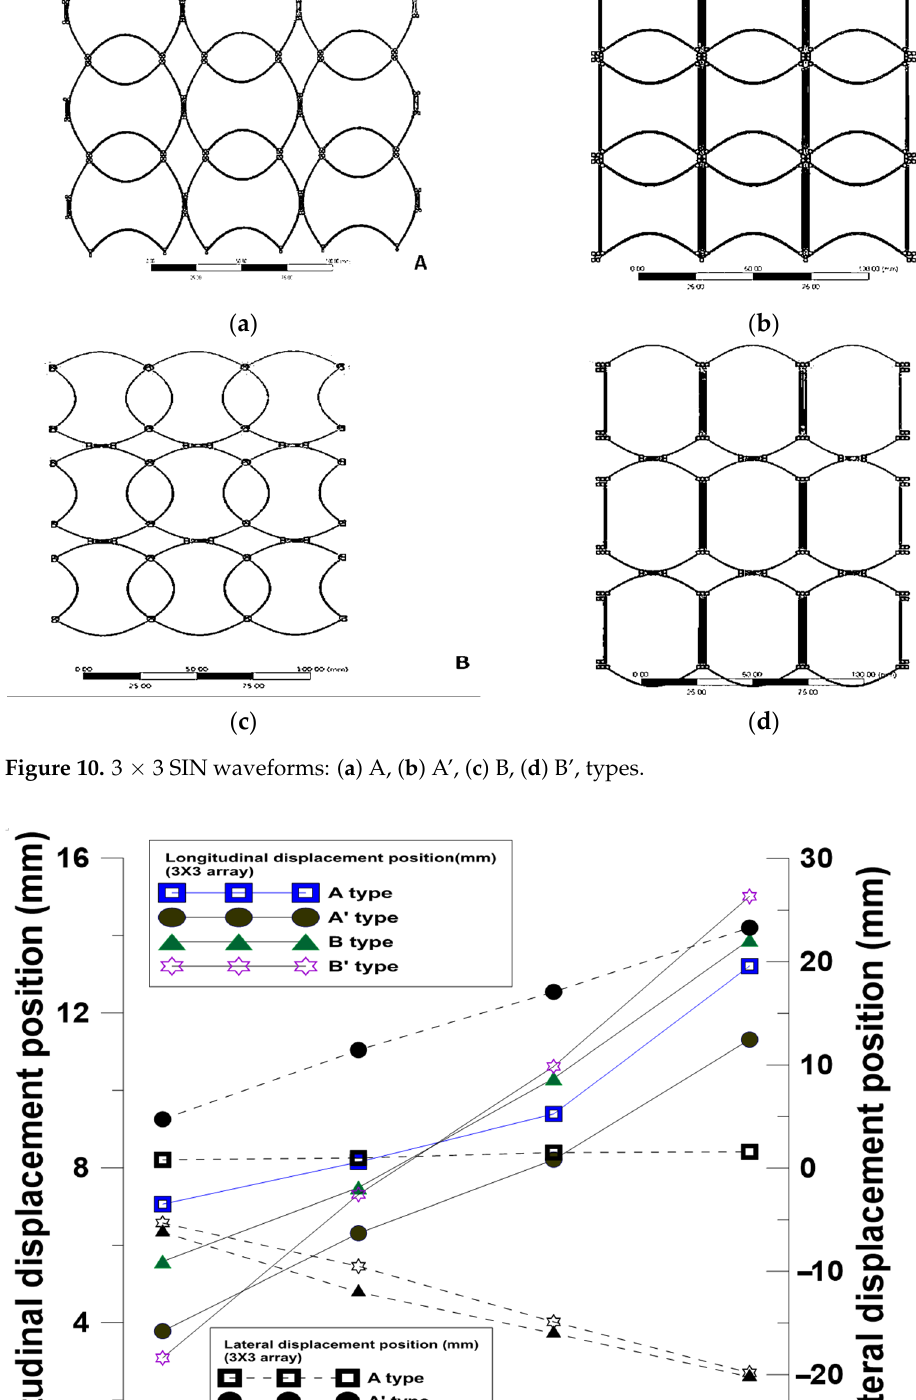
tures were compared and analyzed.